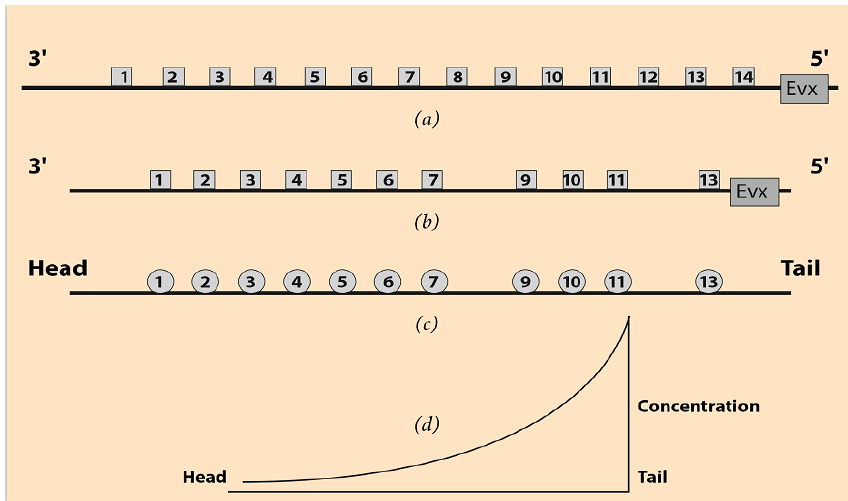
Figure 1. Ordering of Hox genes and the series of the ontogenetic units. ( a ) Hox gene ordering of a (theoretical) common ancestor. Gene Evx is located next to the 5’end of the Hox cluster. ( b ) Ordering of the mouse HoxA cluster. Hox8 and Hox12 are missing. ( c ) The corresponding ontogenetic units of the mouse along the A-P axis. ( d ) The steady-state monotonic concentration gradient of a morphogen. The peak is at the tail region.